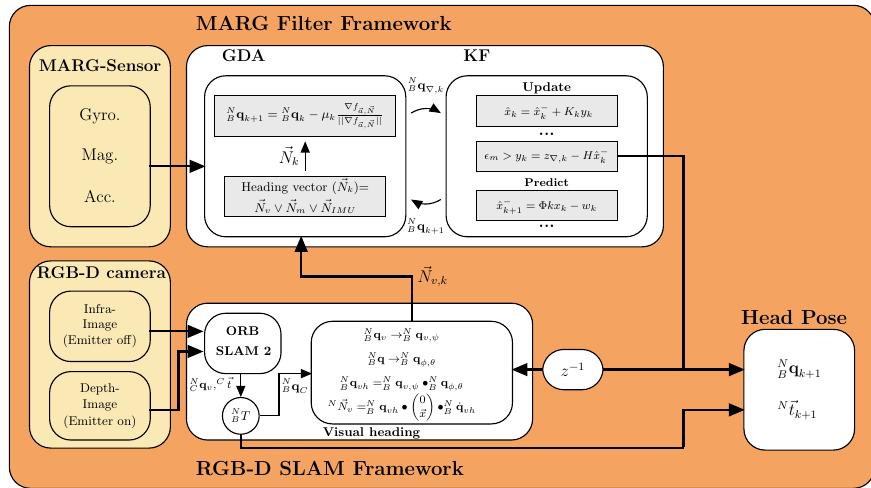
Figure 4. Block diagram of the data fusion software for head pose estimation. The ORB SLAM 2 node calculates a complete pose in the camera frame which is transformed into the MARG-sensors navigation frame. The translation vector C (cid:126) t is transformed into the world coordinate system, forming N (cid:126) t and is directly used as the true head position. The head orientation estimation N